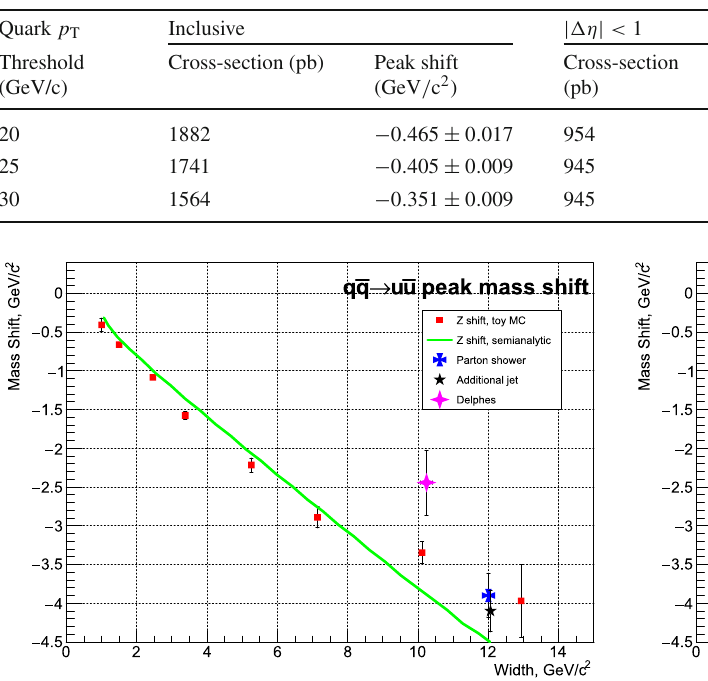
Table 2 The electroweak cross-section accepted within a window of 89–93 GeV/c 2 in m uu , selecting the Z peak, as well as the fitted shift in that peak due to interference. These are given for various quark p T